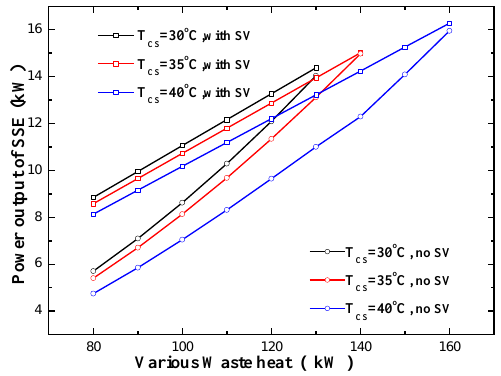
Figure 13. Power output of SSE vs. various waste heat.